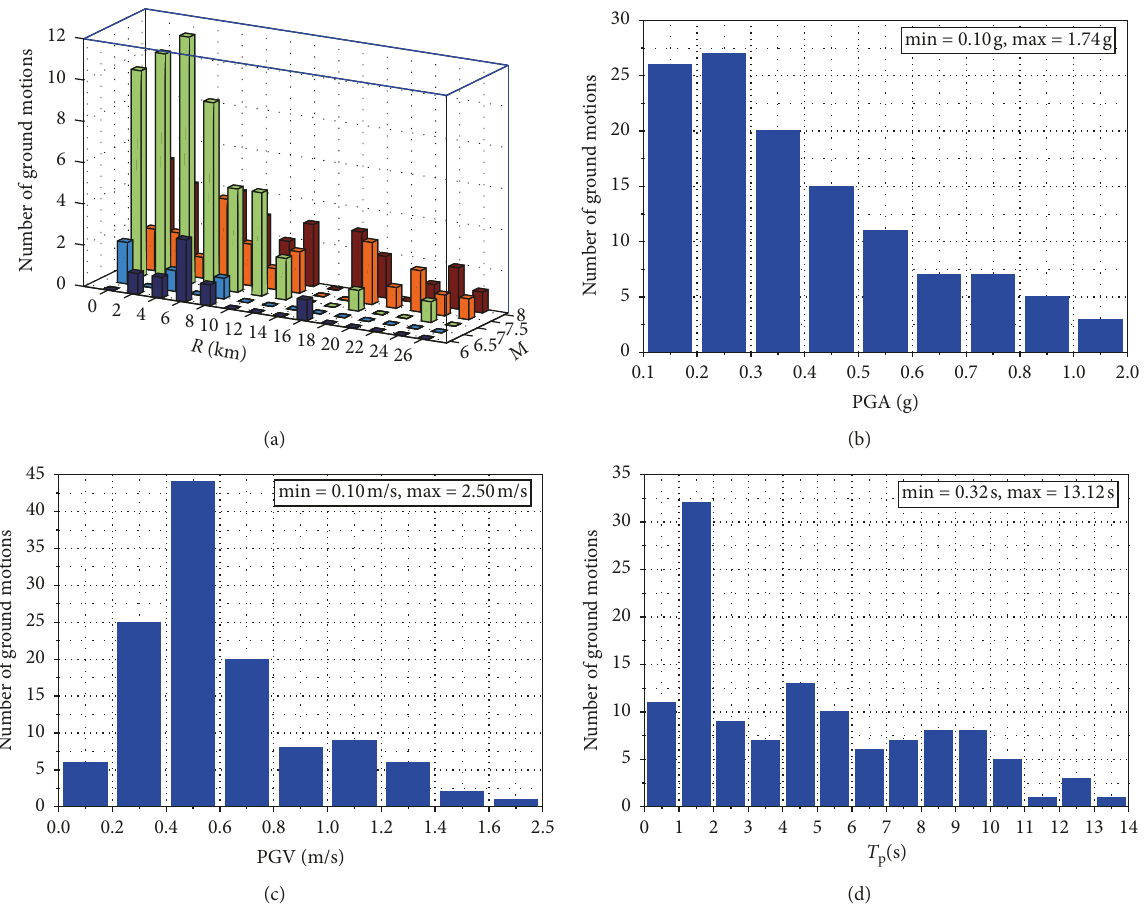
Figure 4: Distribution of pulse-like ground motions with respect to (a) magnitude and source-to-site distance, (b) PGA, (c) PGV, and (d) pulse period T p .